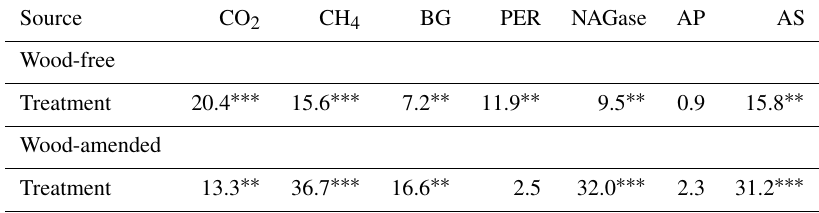
Table 4. Results ( F values and significance) from the one-way ANOVA of cumulative gas production and extracellular enzyme activity (BG: β -glucosidase; PER: peroxidase; NAGase: glucosaminidase; AP: alkaline phosphatase; and AS: arylsulfatase) from soils collected from a coastal freshwater forested wetland and incubated in the laboratory for 98d under dry conditions or fully saturated conditions with either freshwater or saltwater (2.5 and 5.0ppt). Data from wood-free and wood-amended soils were analyzed separately. Source CO 2